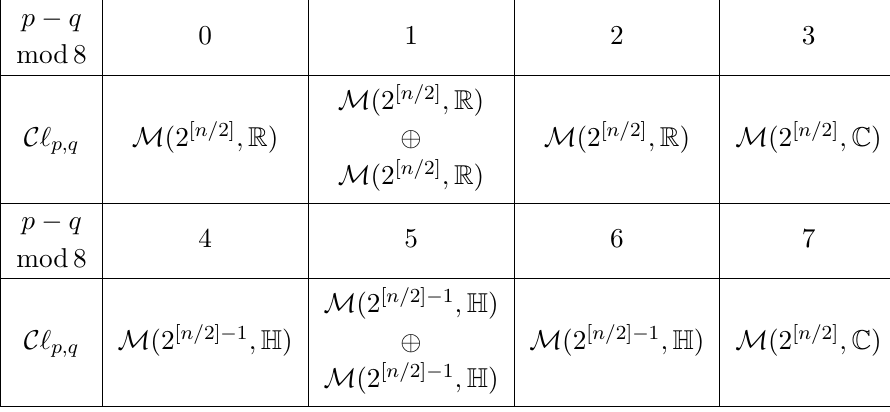
Table 1 . Classi(cid:12)cation of the real Cli(cid:11)ord algebras, for p + q = n